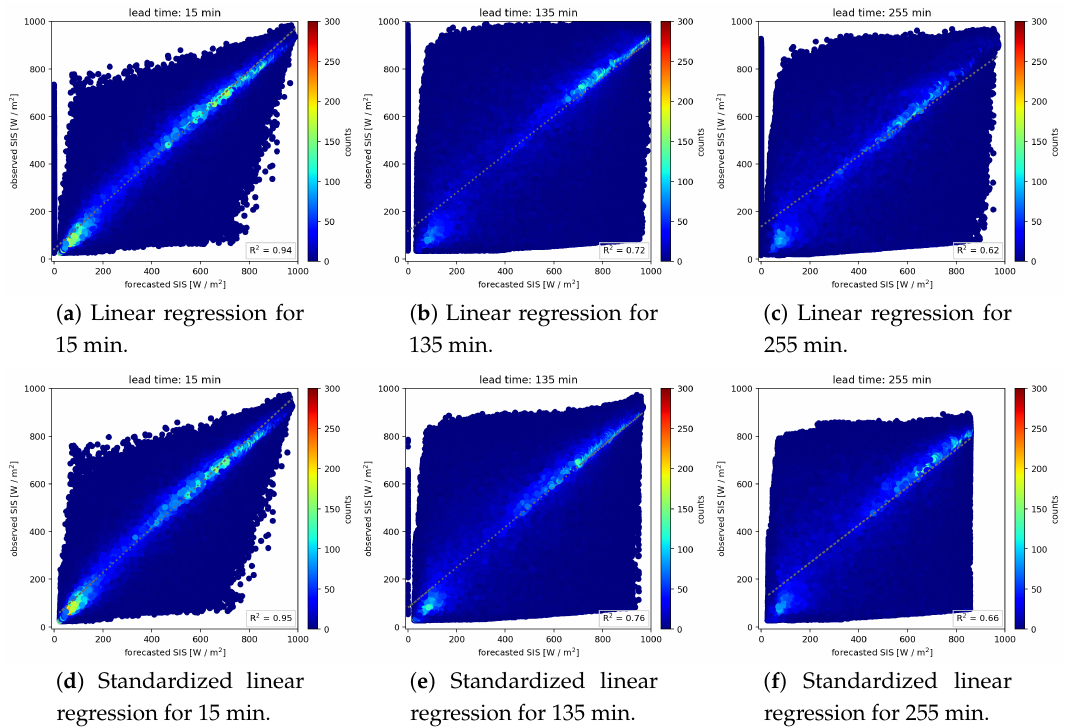
Figure 5. Linear regression of the forecasted and observed absolute solar surface irradiation and standardized solar surface irradiation. Depicted are the results for 15 min ( a , d ), 135 min ( b , e ), and 255 min ( c , f ) of forecast time respectively. R 2 is printed in the lower right corner of every